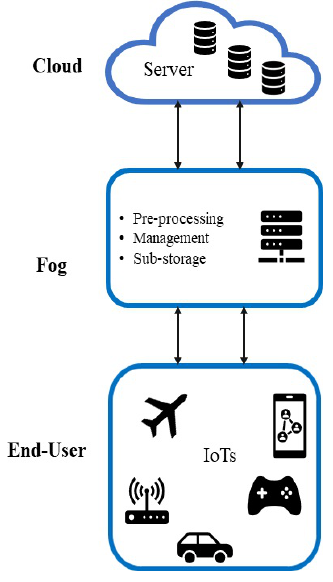
Figure 7. Cloud, fog, and edge